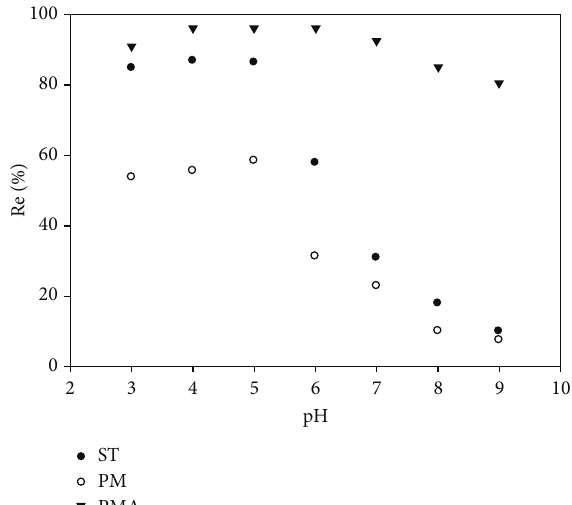
Figure 6: Arsenic removal by using volcanic pyroclastic mixture (PM), scoria-type (ST) material, and activated pyroclastic mixture (PMA), at different